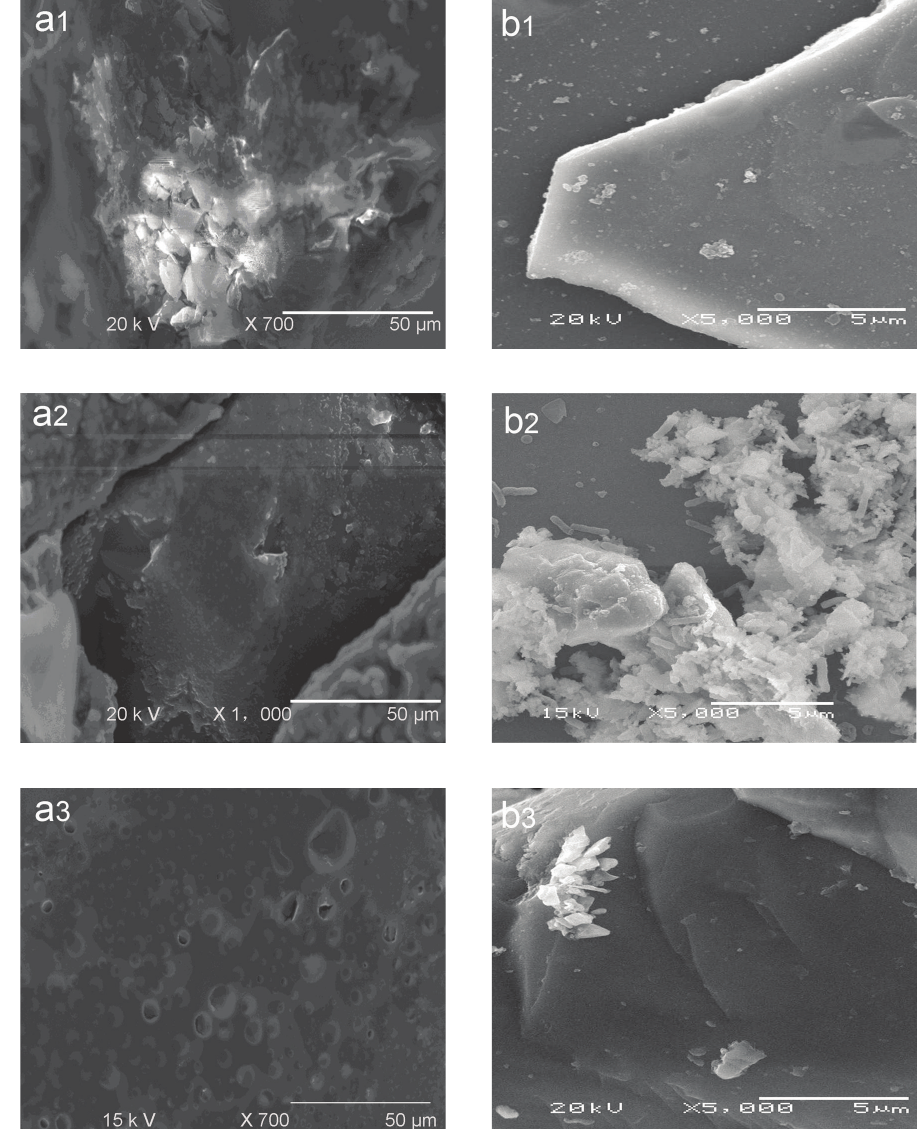
Figure 3: SEM micrographs of biodesulfurization of coal (a1) after 0 day, (a2) after 6 days and (a3) sterile control; bioleaching coal’s pyrite (b1) after 0 day, (b2) after 24 days, and (b3) sterile control after 24